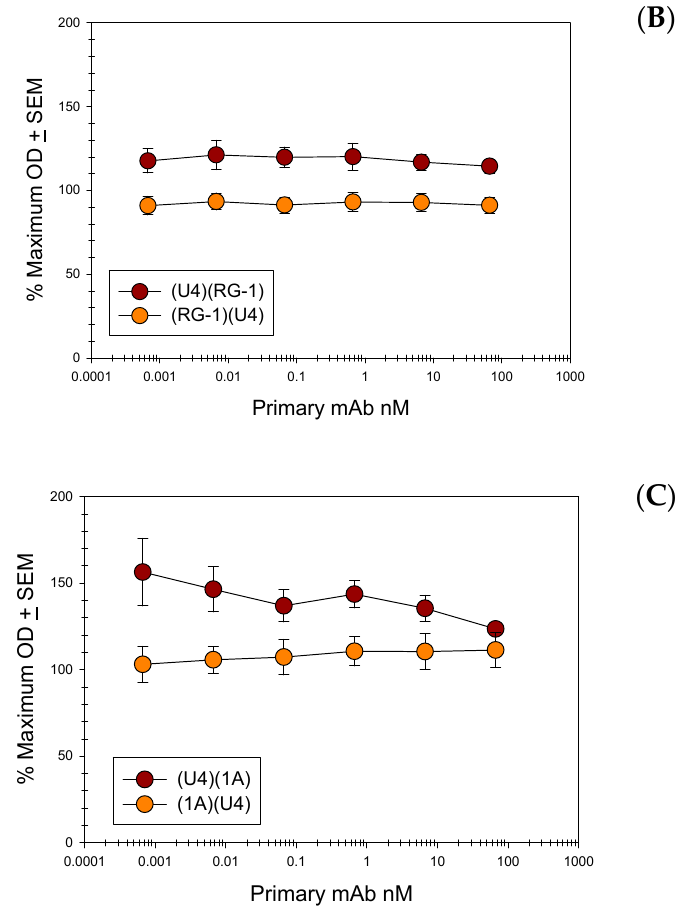
Figure 6. Anti L1 and Anti L2 mAb Direct Binding Competition ELISAs. Pseudovirus 16 particles (500 ng/well) were directly bound to the wells of a microtiter plate. A titration of purified 16.U4 mAb or anti L2 mAb (L2.1A, L2.2E, or RG-1) was added to particles. A constant concentration (66.6 nM) of a reciprocal purified mAb, 16.U4 or an anti L2 mAb, was subsequently added to the virus particles and binding of this antibody was detected with an isotype specific alkaline phosphatase (AP)-conjugated secondary mAb. The % maximum OD is reported as an average of three separate assays. A Student’s t -test was used to assess the statistical significance of each plotted point relative to the minimum concentration of titrated primary mAb. None of the p values were ≤ 0.05. ( A ) Direct competition between 16.U4 mAb and RG-1 mAb. ( B ) Direct competition between 16.U4 mAb and L2.2E mAb. ( C ) Direct competition between 16.U4 mAb and L2.1A.